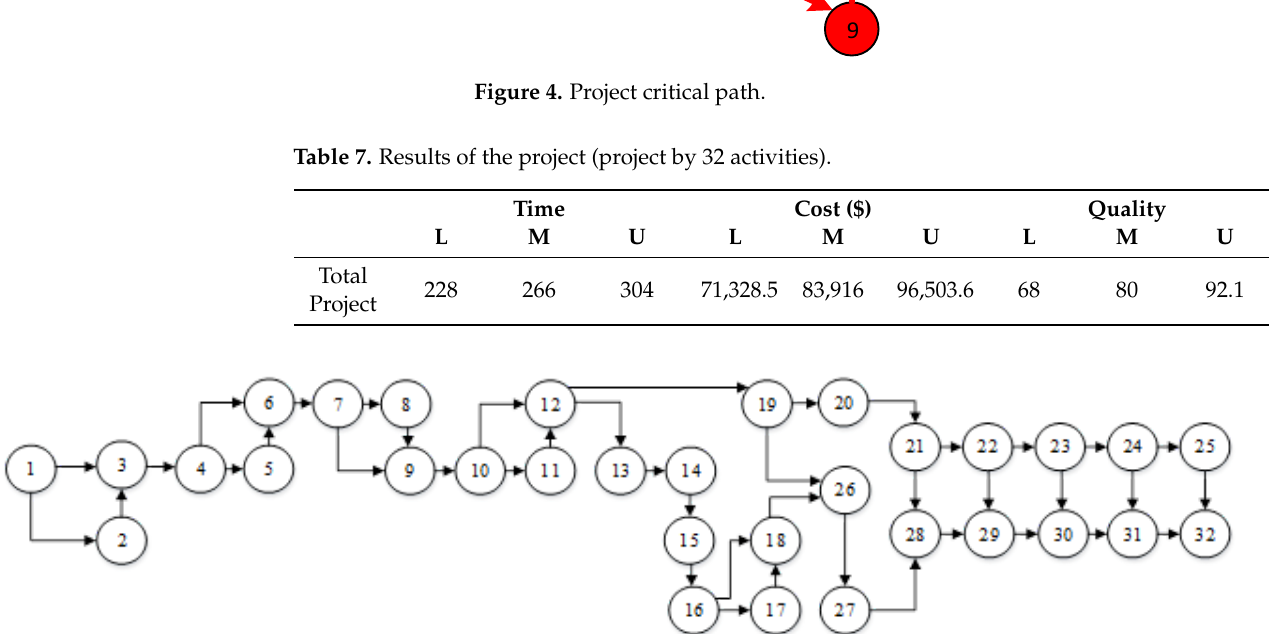
Figure 5. Project network (32 activities). Table 6. Results of fuzzy TOPSIS (project by 32 activities).